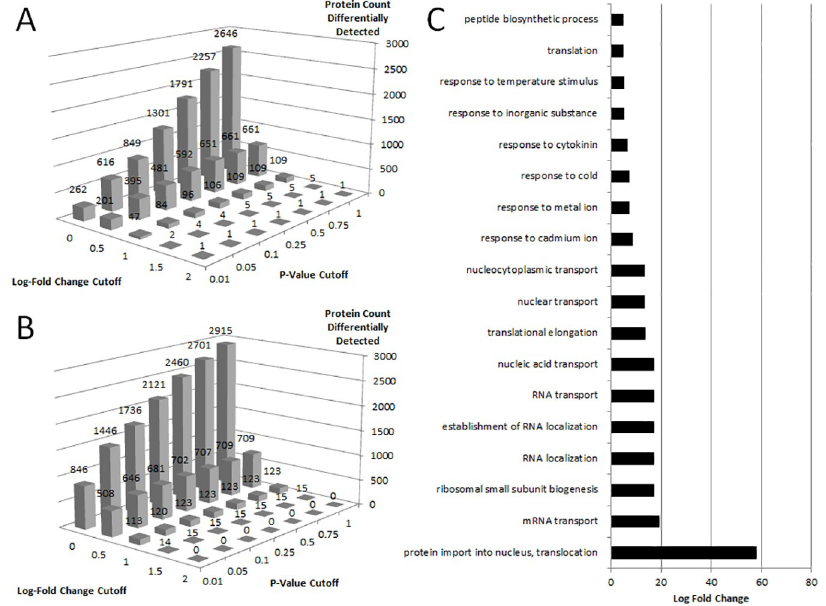
Fig 2. Proteomic analysis of RNAlatervs. Liquid N 2 treated samples. The numberof A) solubleproteins and B) membraneproteins considered significantly differentially abundantbetweentreatments. C) The log- fold enrichment of the GO terms for biologicalprocessesfor the proteins detected with a log-foldchange ± 1 (p (cid:20) 0.05). All reported GO terms are significantat a p-value of 0.05 or